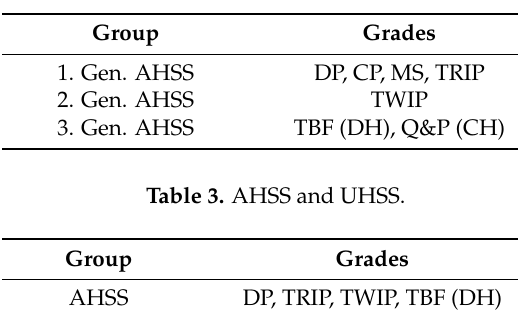
Table 2. 1., 2. and 3. Gen. AHSS.